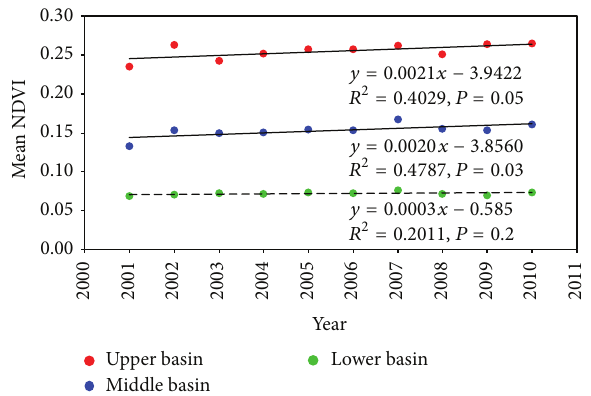
Figure 4: Vegetation evolutions of the upper, middle, and lower basins. ∗ Regression that is significant ( 𝑃 ≤ 0.05 ) or nonsignificant ( 𝑃 > 0.05 ) is presented with solid line or dashed line,